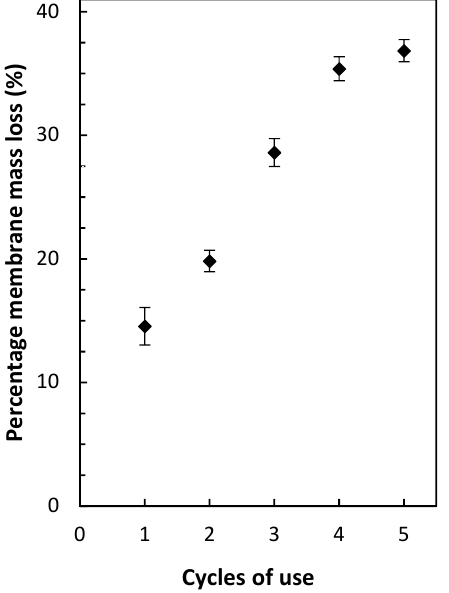
Figure 10. Percentage mass loss of PIMs containing PVDF-HFP/Aliquat ® 336/DBP 50/40/10 wt% after each extraction/back-extraction cycle. Error bars = ±SD.